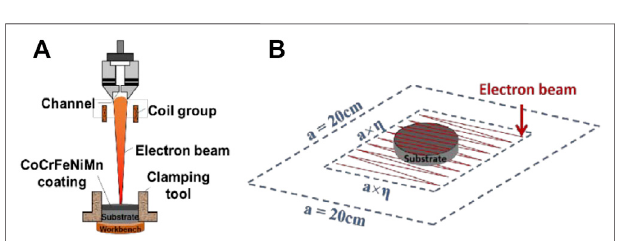
FIGURE 2 | Transient thermal shock tests of CoCrFeNiMn HEA coatings. (A) Schematic diagram of transient thermal shock experiment by EB; (B) Scanning mode of the EB during the transient thermal shock tests.